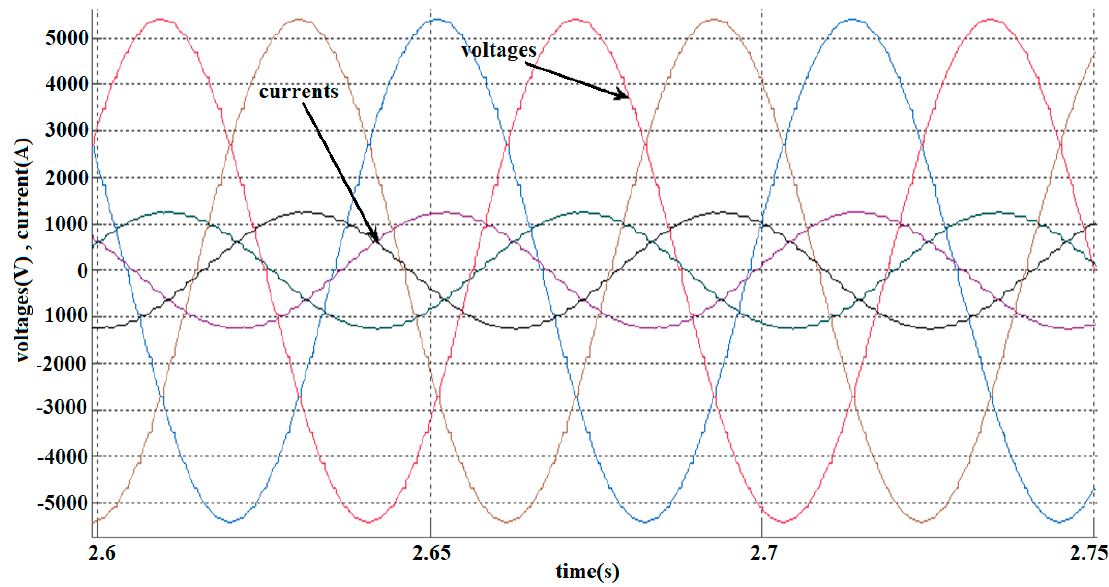
Figure 36. Terminal voltage of the load and load current.